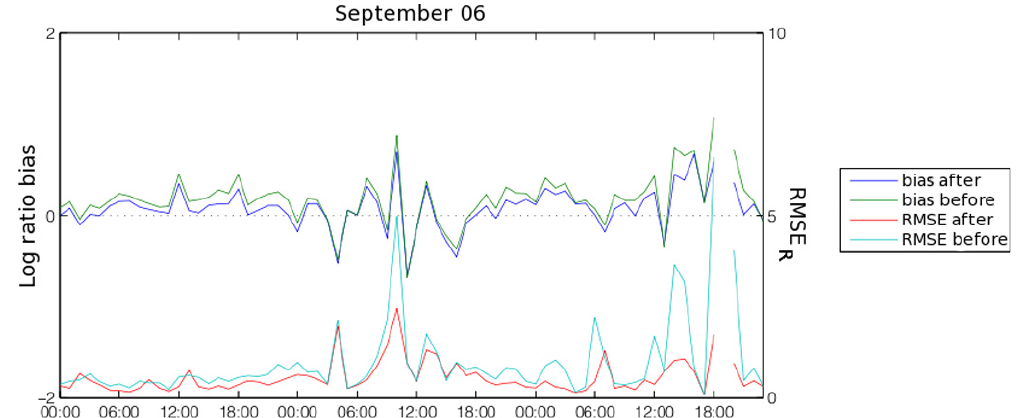
Fig. 12. Validation results for the September 2006 event before and after applying the advection correction.